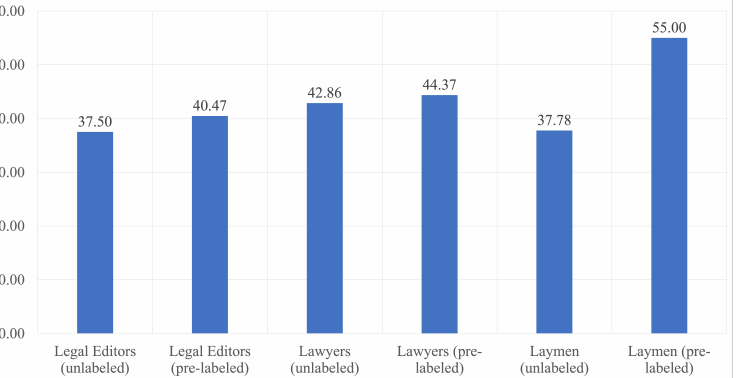
Figure 8. Krippendorff’s Alpha scores in different annotator groups with (pre-labeled) and without machine suggested labels